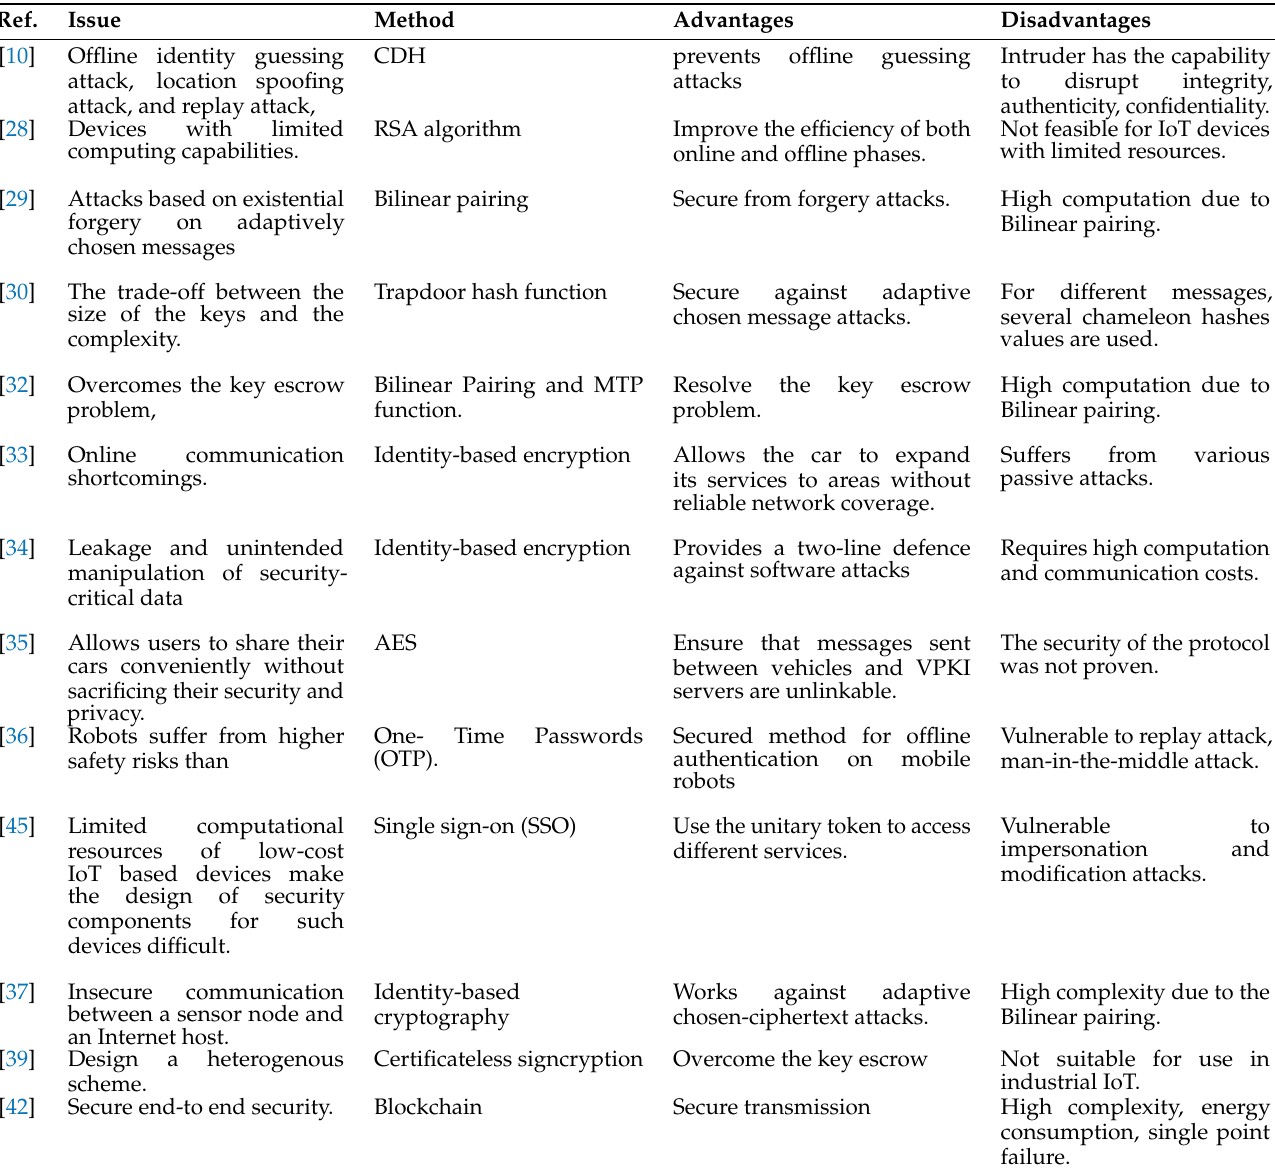
Table 1. Comparison of the existing online–offline authentication